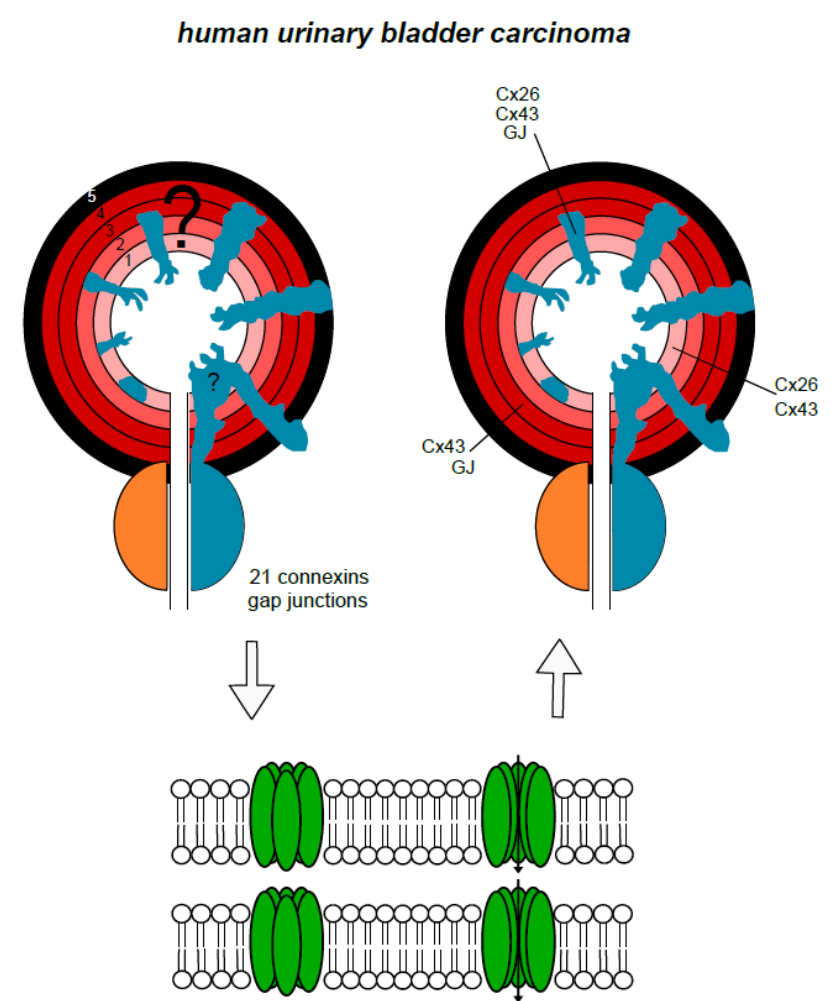
Figure 2. Schematic drawing of the layers and tumor distribution in the human urinary bladder and its cancer. The question marks relating to the expression of connexins in the various layers on the left side are answered, and, on the right side, are answered where possible. Finally, there are indications that connexons and gap junctions are present in the detrusor muscle and adenocarcinoma of the human urinary bladder. (orange = healthy prostate, blue carcinoma, 1 = urothelium, 2 = lamina propria and to some extent submucosa, 3 = detrusor muscle inner layer, 4 = detrusor muscle outer layer, 5 = adventitia).